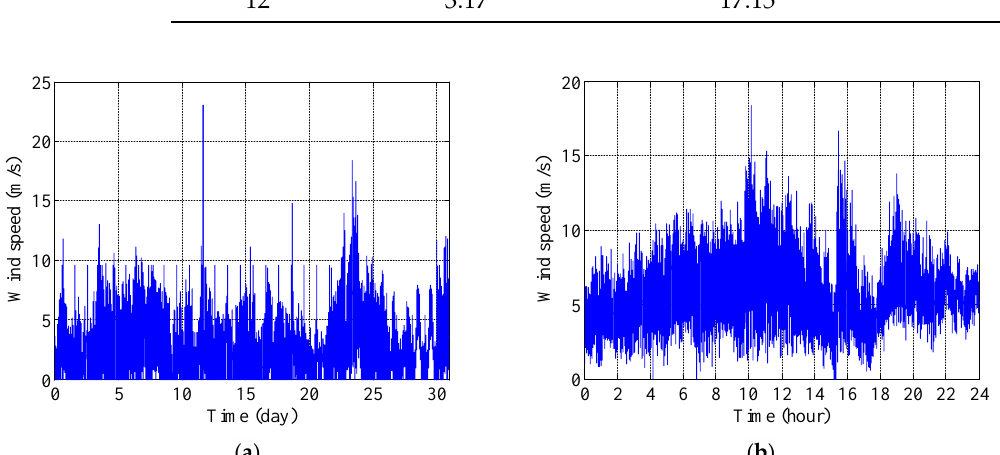
Figure 5. Wind speed–time curves for regular wind. ( a ) 1–31 July. ( b ) 24 July.